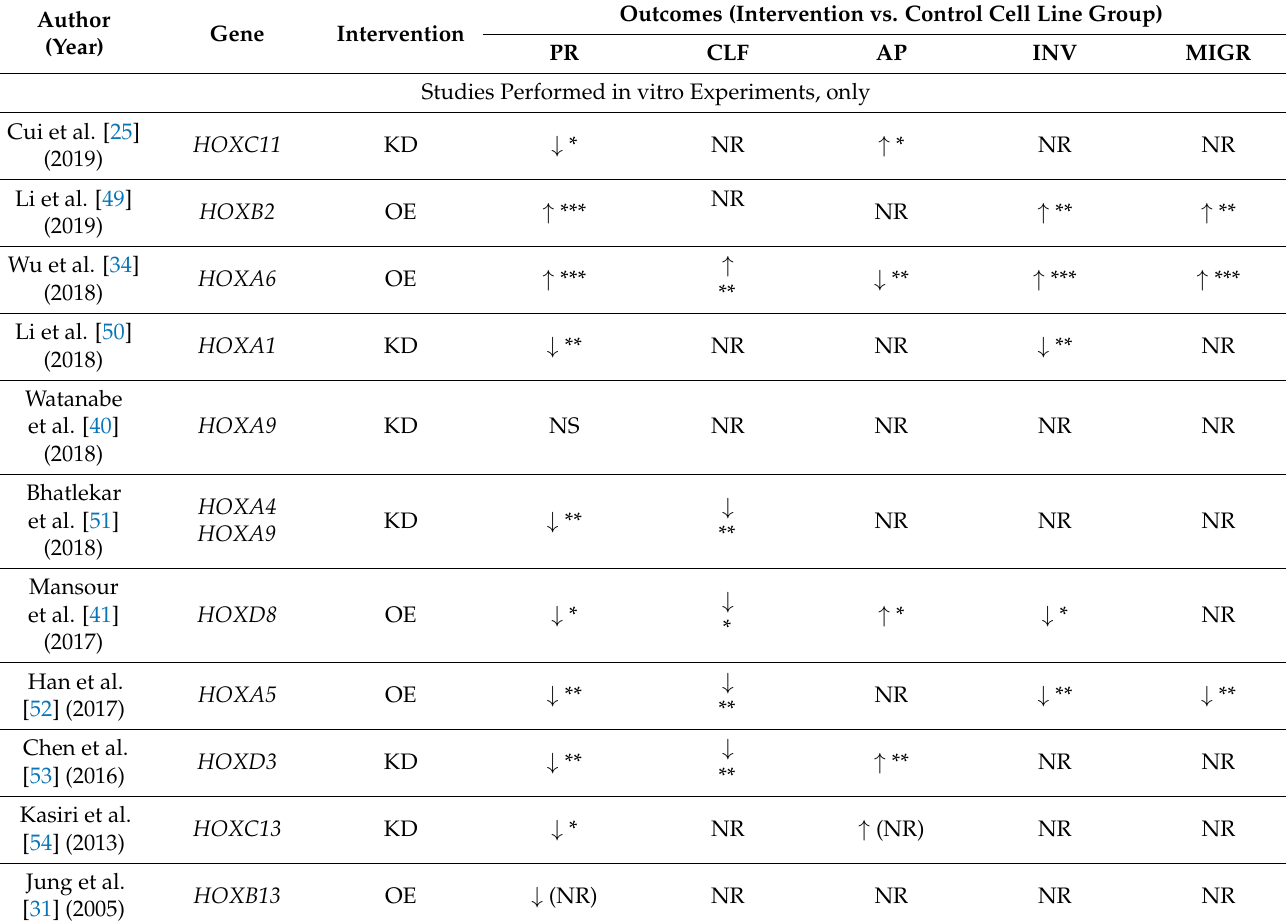
Table 2. Summary of findings of the included studies that performed only in vitro experiments on the functional role of